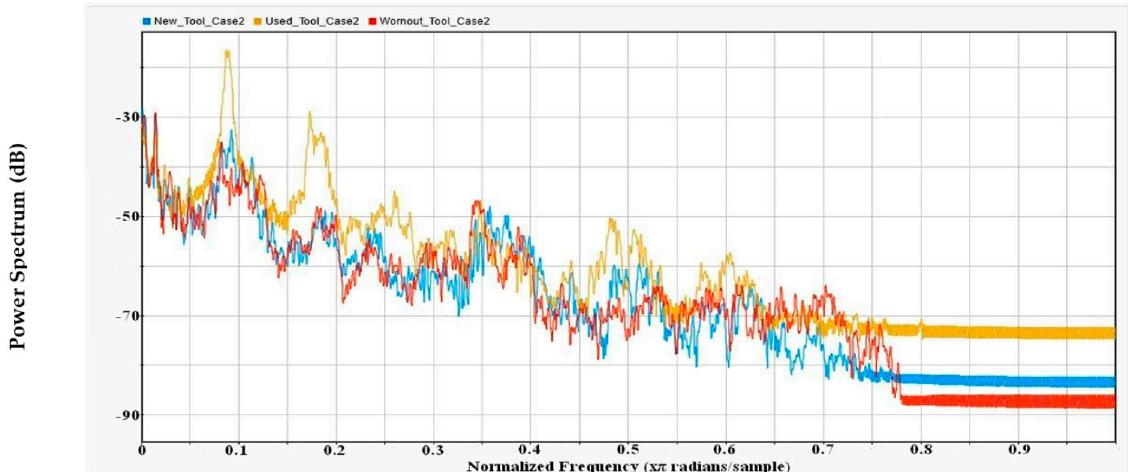
Figure 17. Power spectral density (PSD) for Case-2 of new (blue), used (yellow), and worn-out (red) tool with maximum leakage settings.